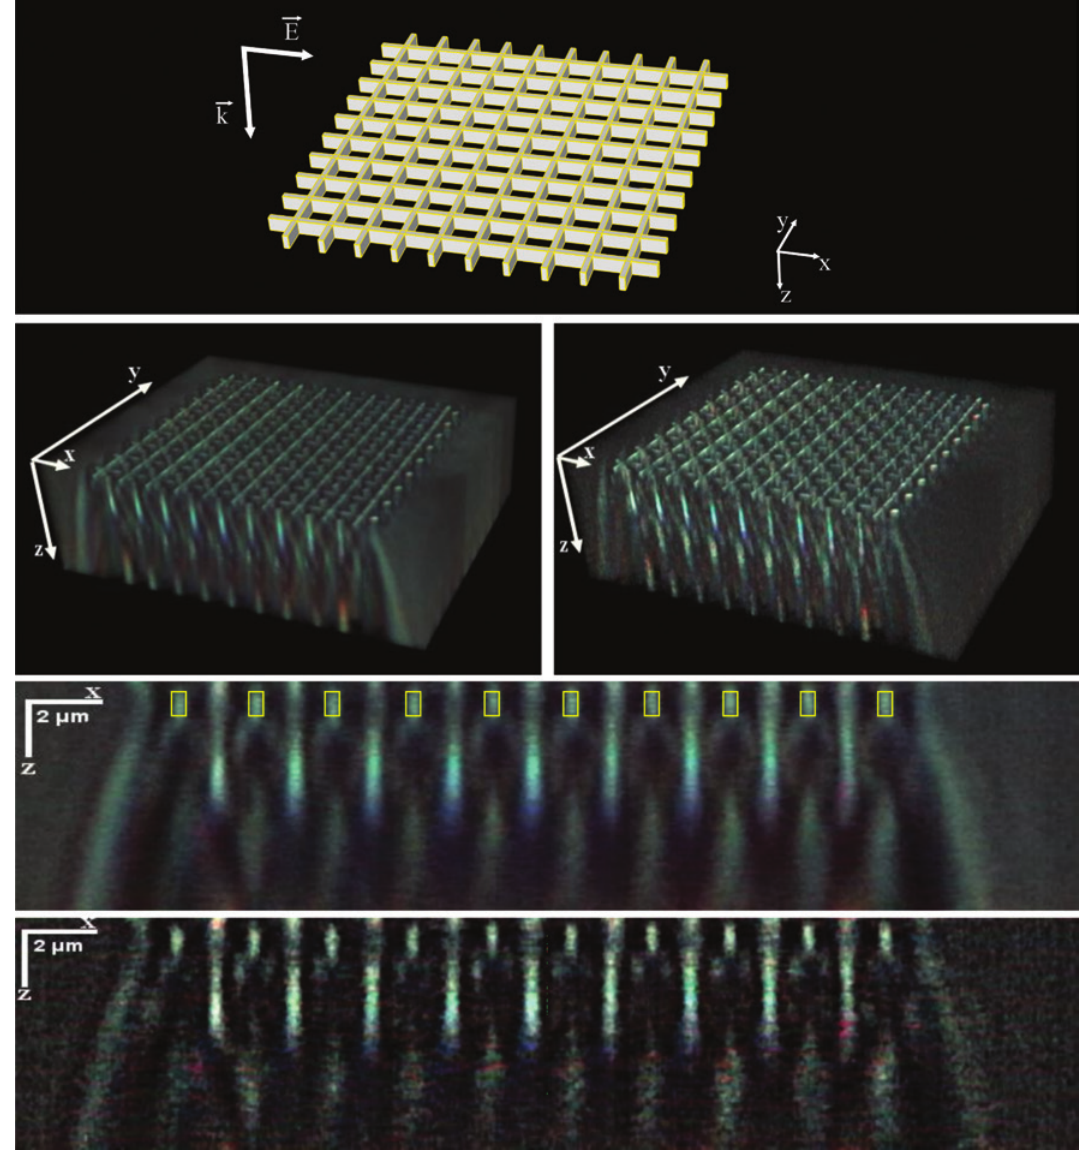
Figure 9: First row: The schematic of the polymer grid. Second row: white-light 3D intensity distributions diffracted by a grid of parallel polymer lines separated by 2 μ m into a borosilicate substrate. Left: raw z-stack images. Right: deconvoluted z-stack images. Third row: x–z projections of intensity distributions from raw data. Fourth row: x–z projections of intensity distributions from deconvoluted